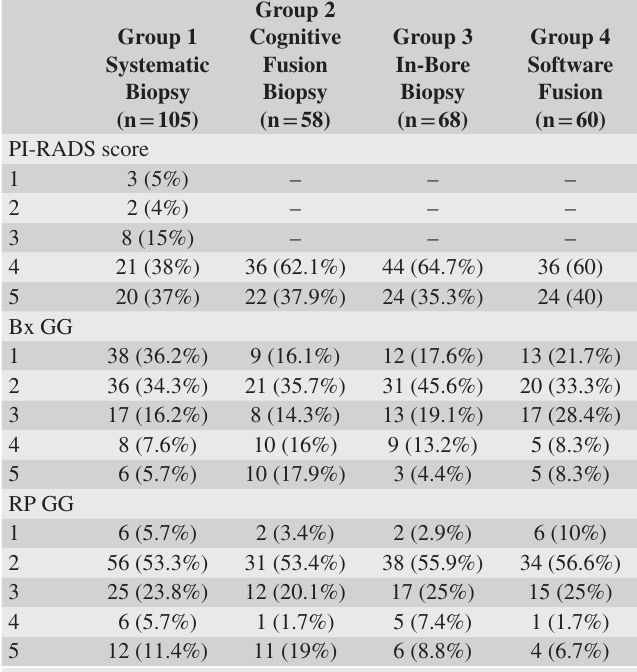
Table 2. PI-RADS Score and ISUD GG Distribution